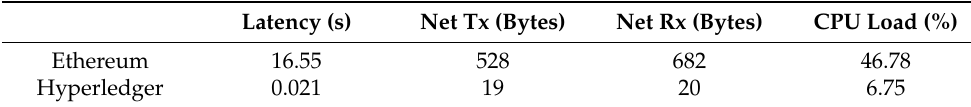
Table 2. Ethereum and Hyperledger performance comparison values